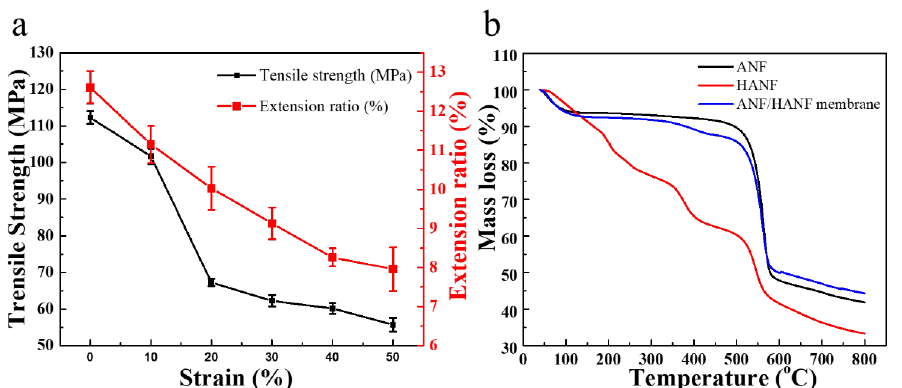
Figure 6. ( a ) Tensile strength and extension of membranes with various HANF contents. ( b ) The thermogravimetric analysis (TGA) curves of ANF, HANF, and ANF/HANF membrane (HANFs composition: 10 wt%).